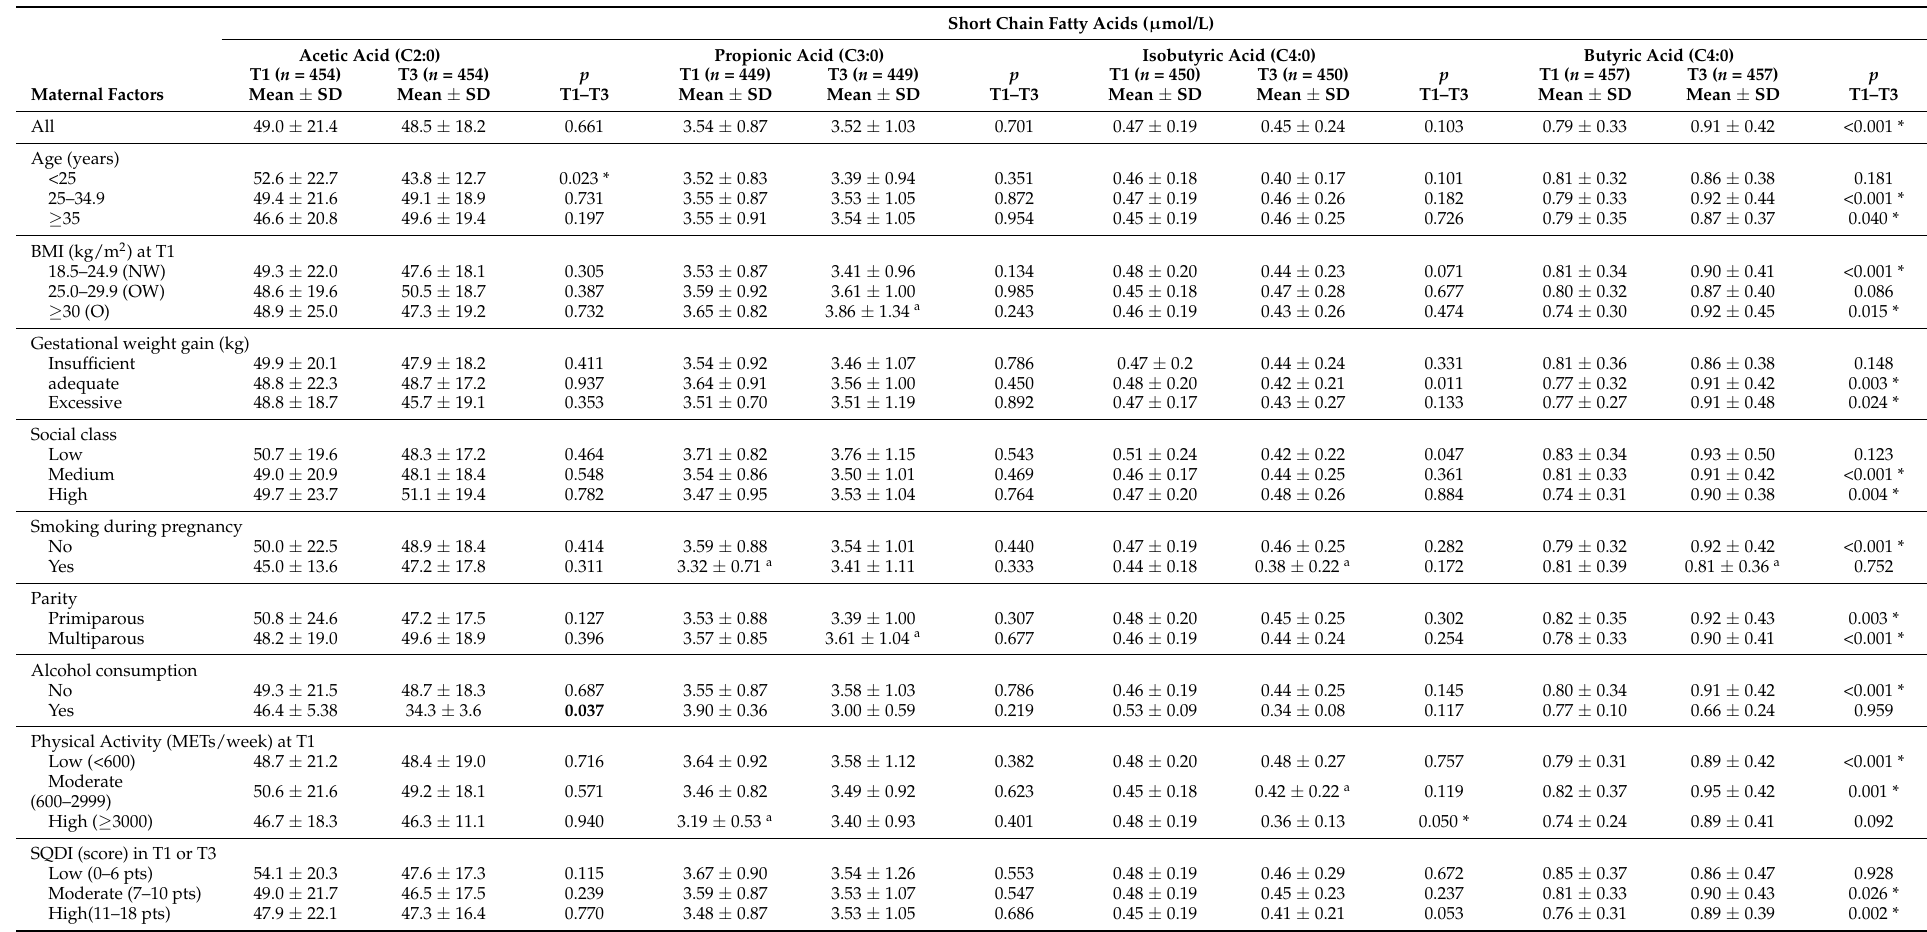
Table 3. Mean of maternal serum short chain fatty acids concentrations by selected sociodemographic and lifestyle characteristics of pregnant women. Short Chain Fatty Acids ( µ mol/L) Acetic Acid (C2:0) Propionic Acid (C3:0) Isobutyric Acid